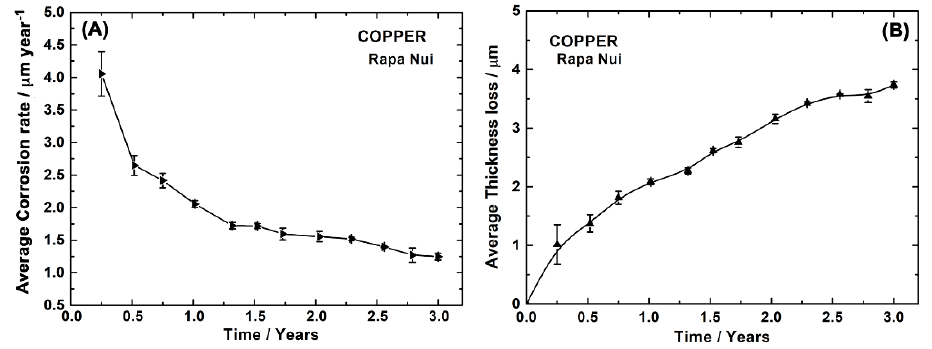
Figure 6. Corrosion rate ( A ) and thickness loss ( B ) of copper as a function of exposure time.